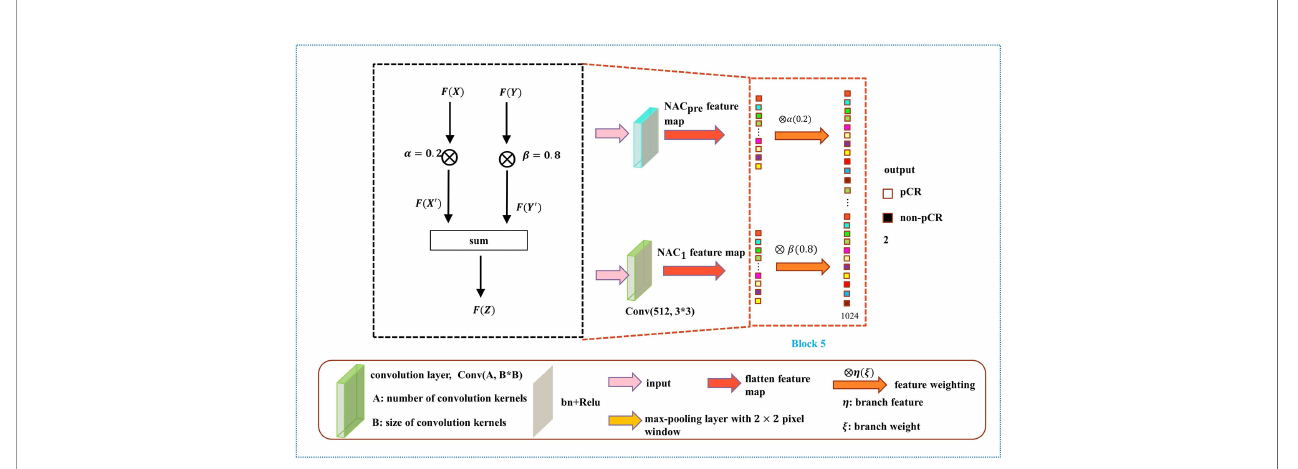
FIGURE 6 | Diagram of the weight assignment method.